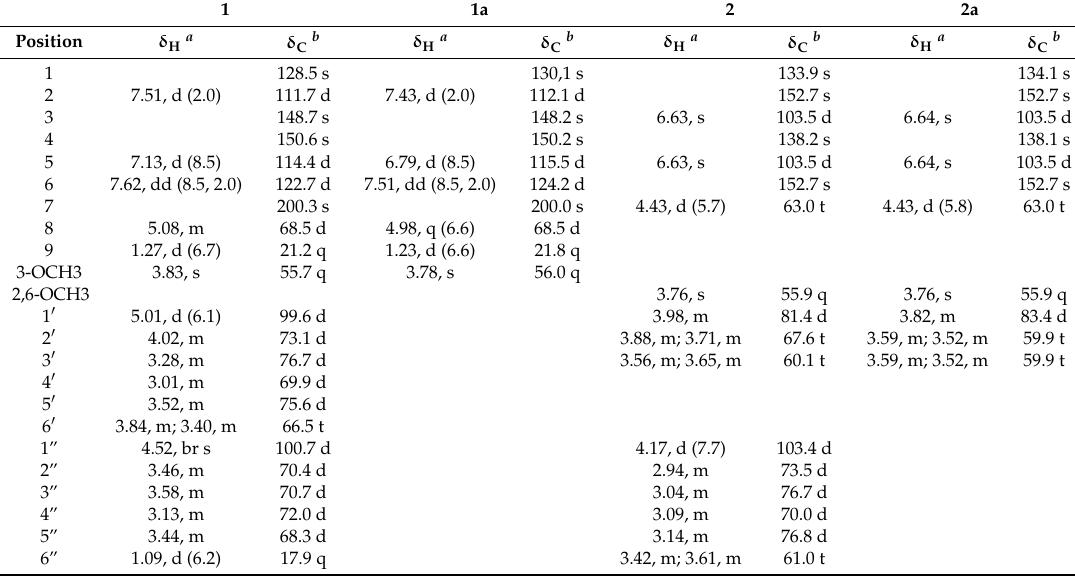
Table 1. 1 H and 13 C-NMR Spectroscopic Data of Compounds 1 , 1a , 2 and 2a ( δ in ppm, J in Hz). 1